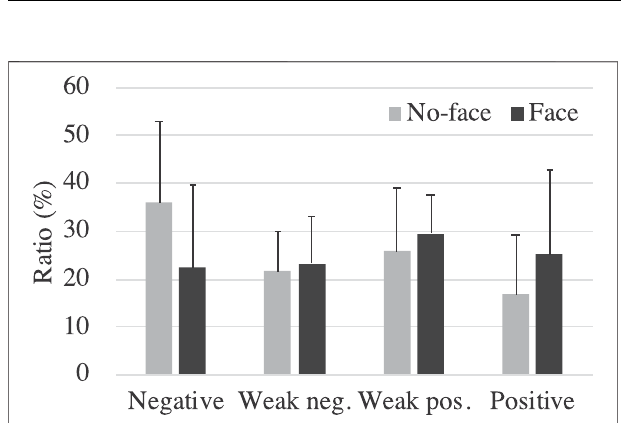
FIGURE 4 | Average ratio of robot ’ s emotional states during